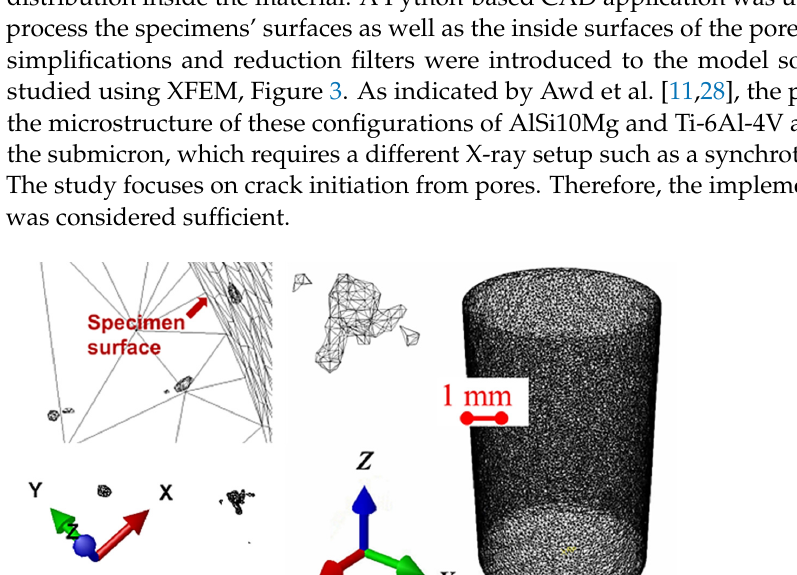
Table 2. Energy release rate crack propagation parameters according to Equation